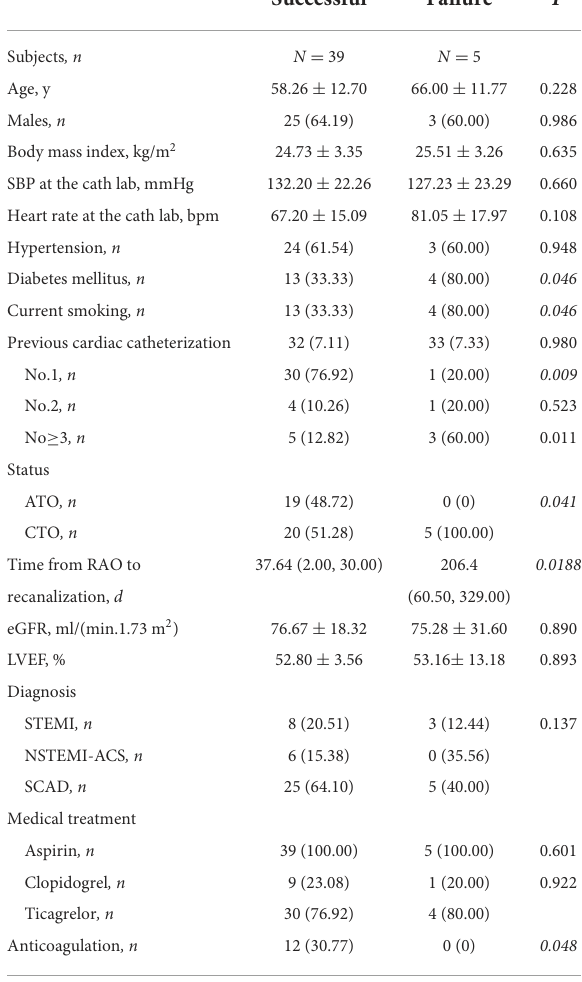
TABLE 1 Baseline characteristics of the dTRA and TRA groups *